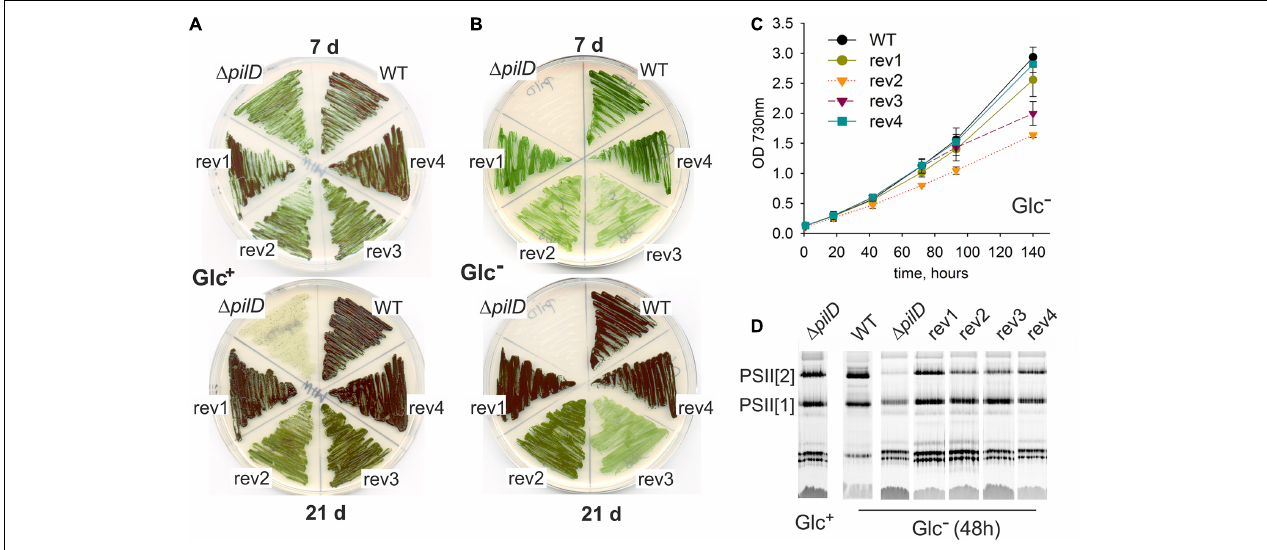
FIGURE 2 | Characterization of spontaneous revertants derived from the (cid:49) pilD strain. (A) Growth on agar plates was assessed for the WT, (cid:49) pilD mutant and the four isolated (cid:49) pilD revertants (rev1–4) at the 7th and 21st day of cultivation under mixotrophic conditions and (B) under photoautotrophic conditions. (C) Photoautotrophic growth of the WT and rev1-4 strains. Cells were grown in liquid culture and optical density was monitored spectroscopically. (D) Membrane protein complexes, isolated from the WT and mutant strains grown for 48 h in Glc − , were solubilized and separated by CN-PAGE. The loading corresponds to the same number of cells per lane based on OD 730 ; 4 µ g of Chl for WT. After separation, the gel was scanned (see Supplementary Figure 2 ) and PSII complexes were detected by Chl fluorescence after excitation by blue light in LAS 4000 (Fuji). PSII[1] and PSII[2] indicates the monomeric and dimeric PSII, respectively.